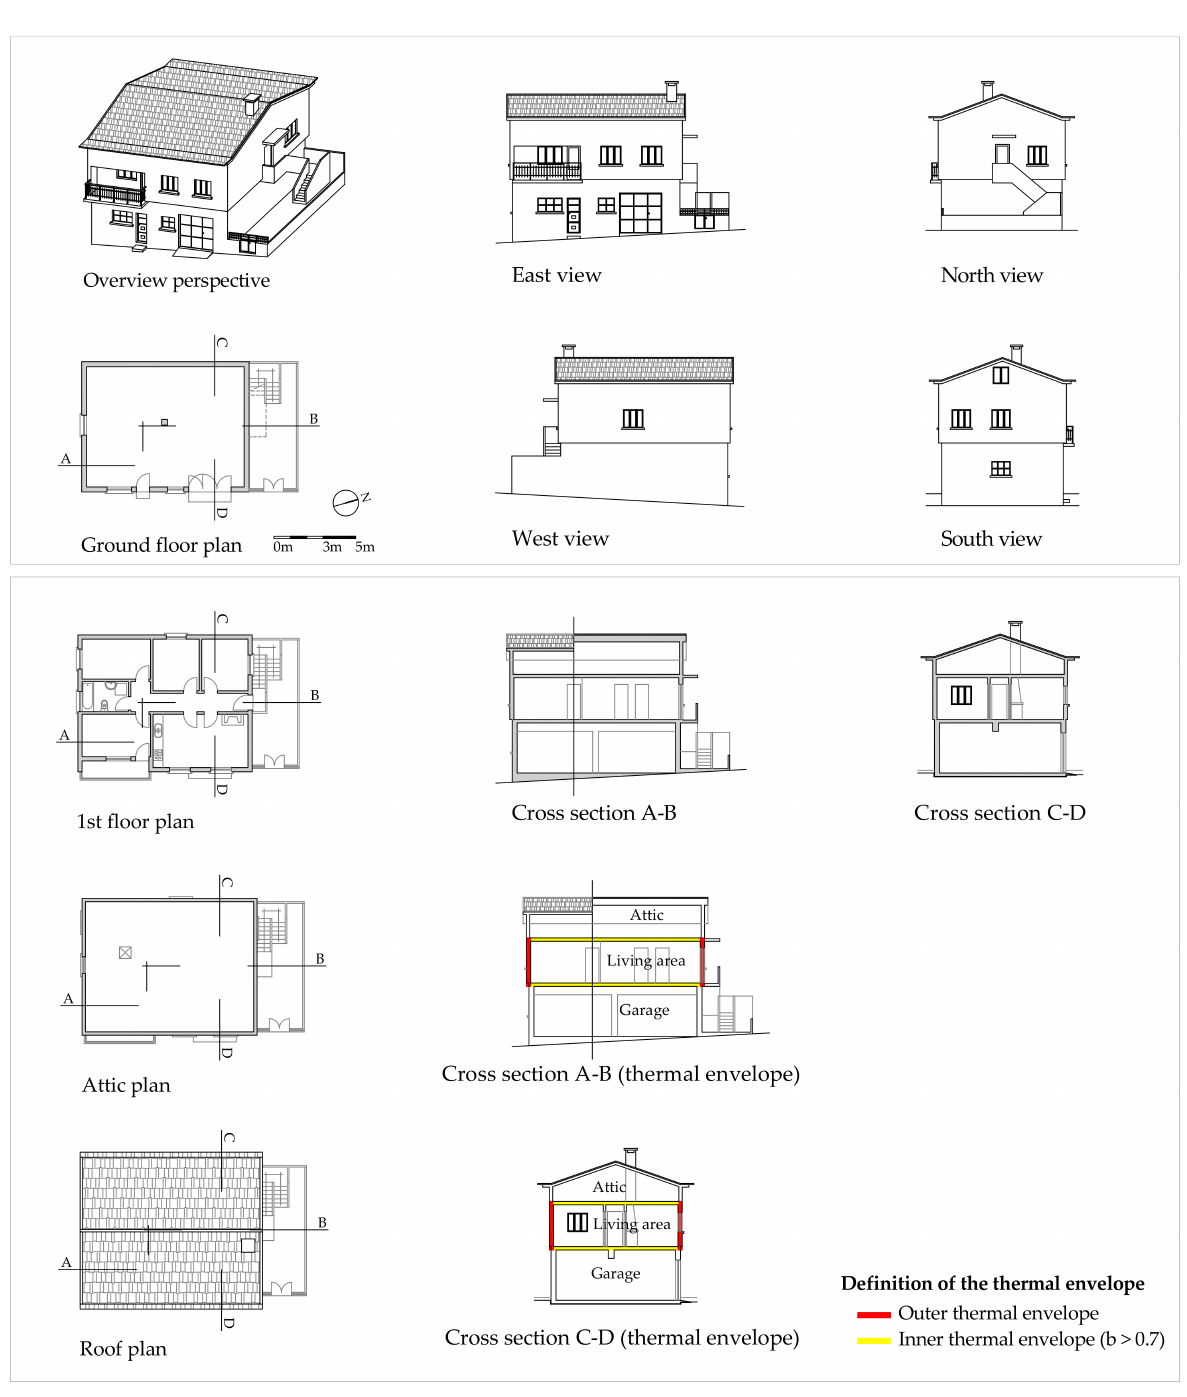
Figure 4. Case Study